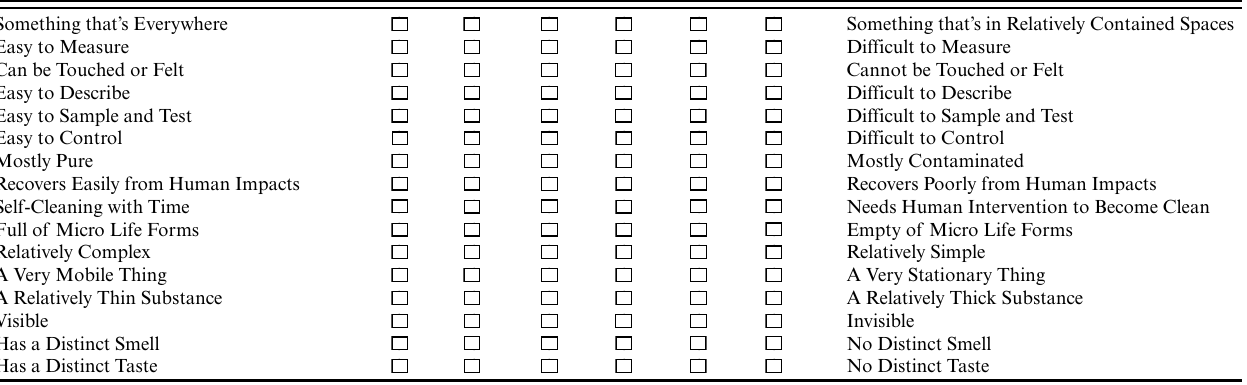
Table 1 . Initial psychometric rating scale. Participants were asked to quickly mark the box closest to the wording describing how they think about [air, water, or soil]. Contrasting endpoint design was modeled after prior hazard risk studies. Something that’s